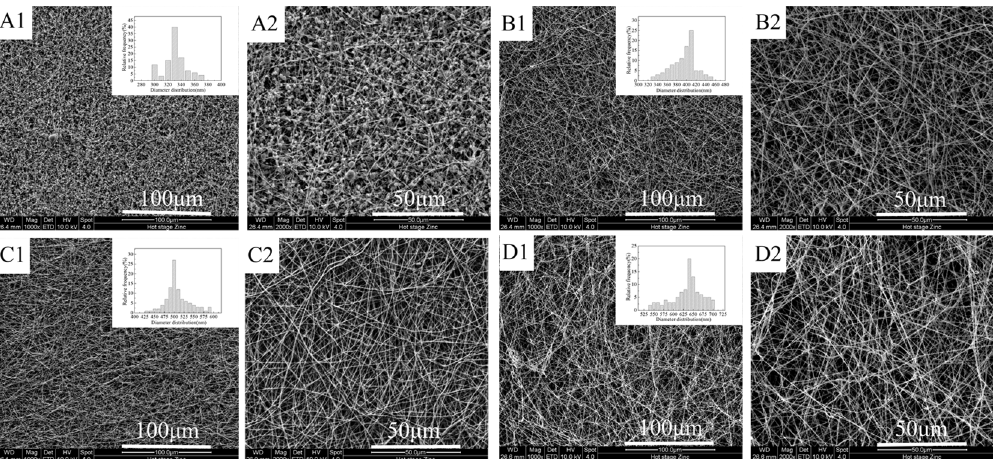
Figure 5. Surface morphologies of nascent ultrafine fibrous FEP porous membranes at different FEP/PVA mass ratios ( A ): 10:1; ( B ): 8:1; ( C ): 6:1; ( D ): 4:1; 1: 1000× surface; 2: 2000× surface).